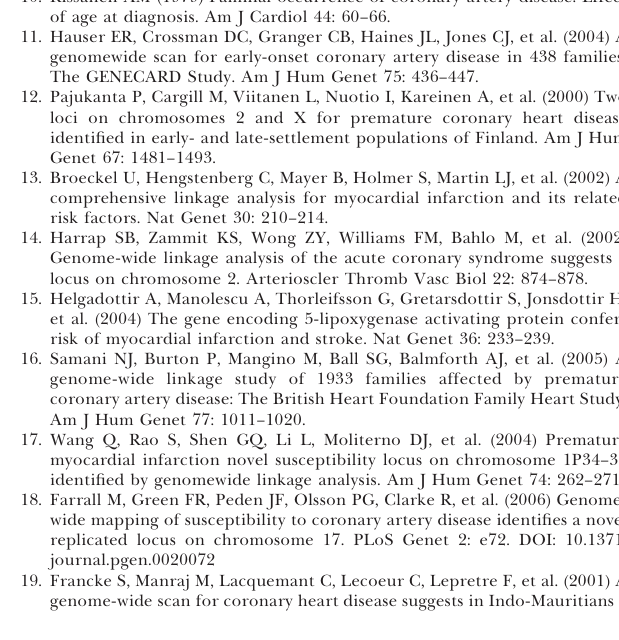
Table S2. Replication of GATA2 SNPs Associated with Early-Onset CAD Adjusting for Race and Sex Found at DOI: 10.1371/journal.pgen.0020139.st002 (15 KB XLS). Table S3. Replication of Allele Direction of rs2713604 and rs3803 in GENECARD Table S4. The Risk and Protective Alleles of rs2713604 and rs3803 Do Not Occur on the Same